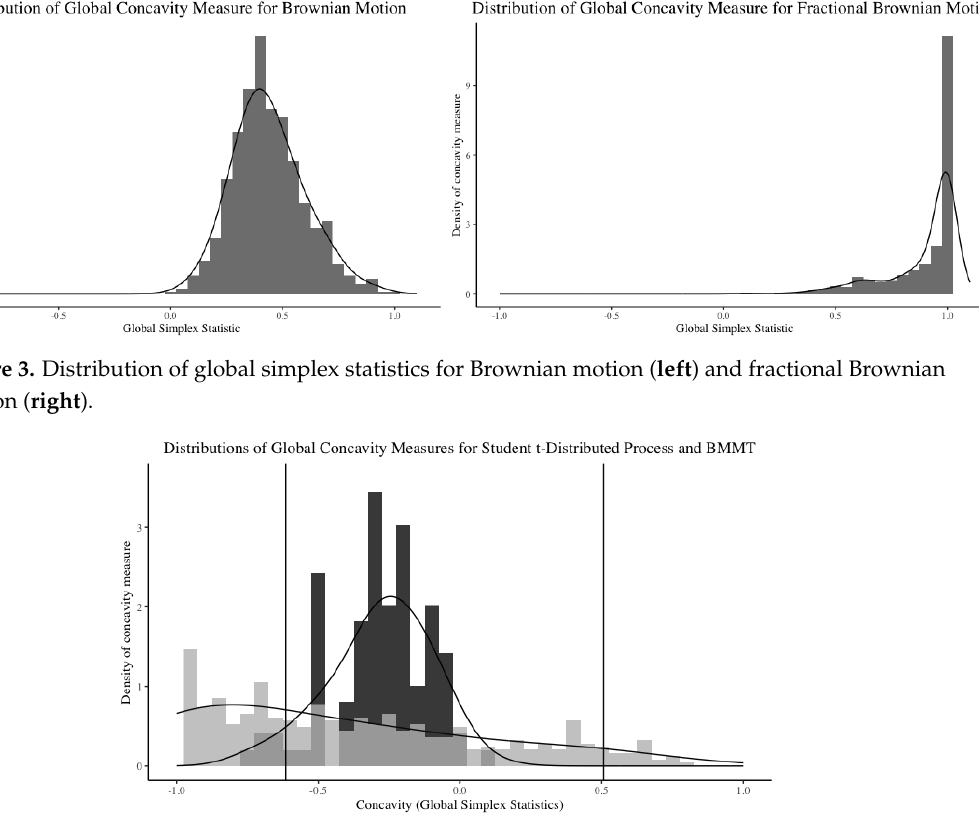
Figure 4. Distributions of global simplex statistics for Student t -distributed process (black) and the simulated BMMT with log-normal multiplicative cascade (grey) around tail index 3.06. The two vertical lines represent the 95th percentile for the simulated BMMTs ( left ) and 5th percentiles for the Student t -distributed processes, respectively ( right